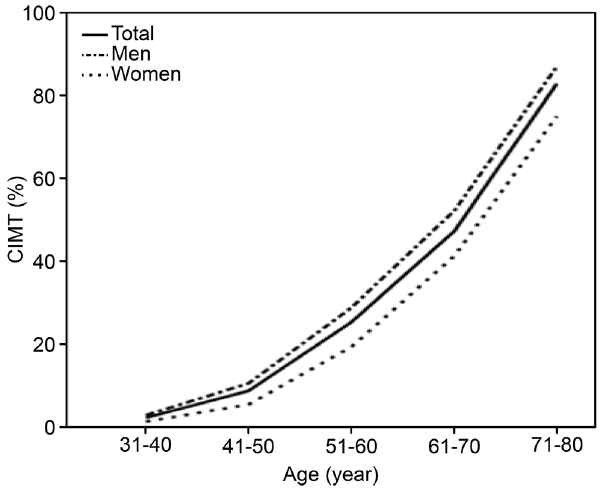
Figure 1. The incidence of carotid atherosclerosis in different age groups and genders.